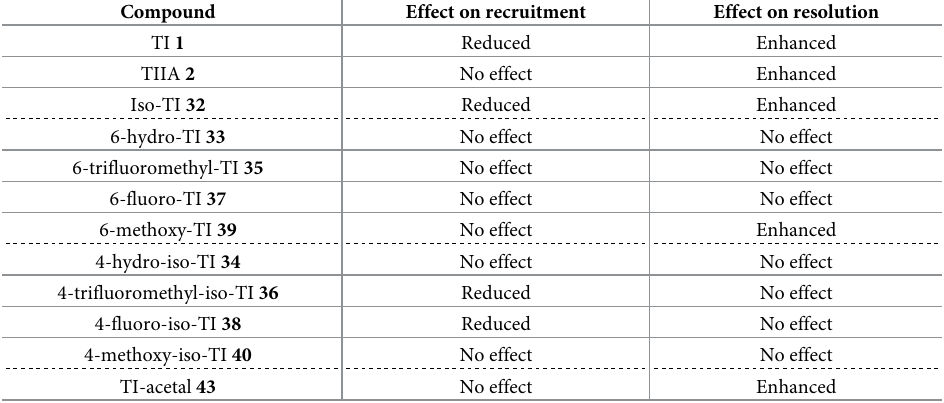
Table 1. Summary of the effects of various tanshinones and isotanshinones on neutrophil recruitment and resolu- tion of neutrophilic inflammation in vivo .